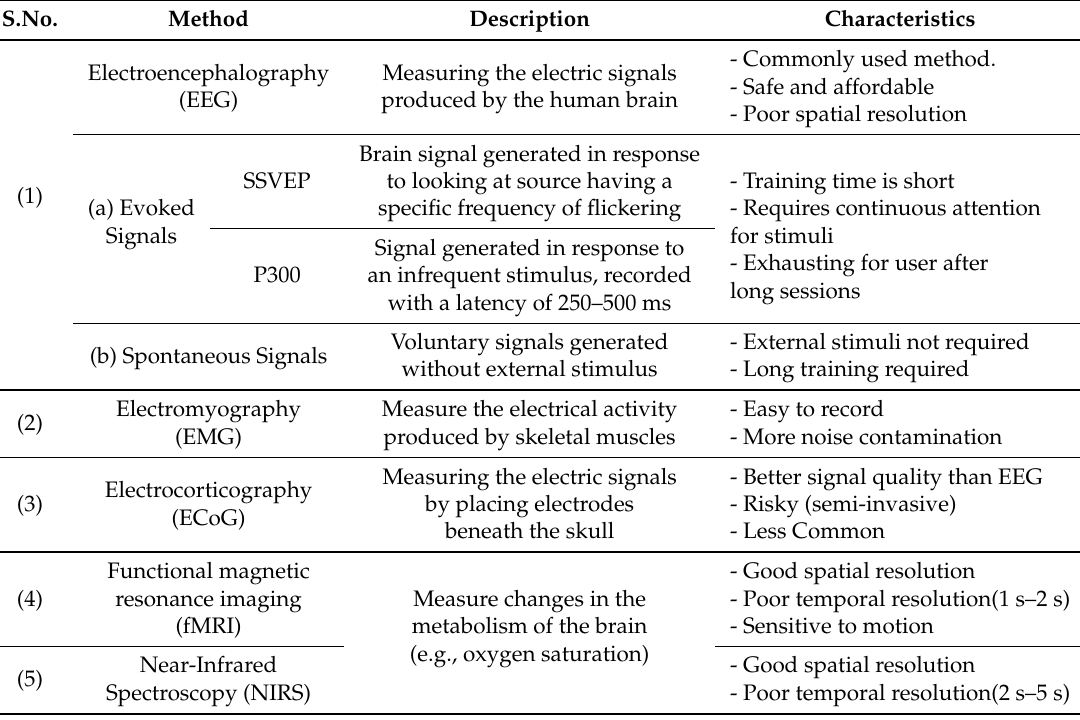
Table 1. Comparative Analysis of Various Methods used for Recording